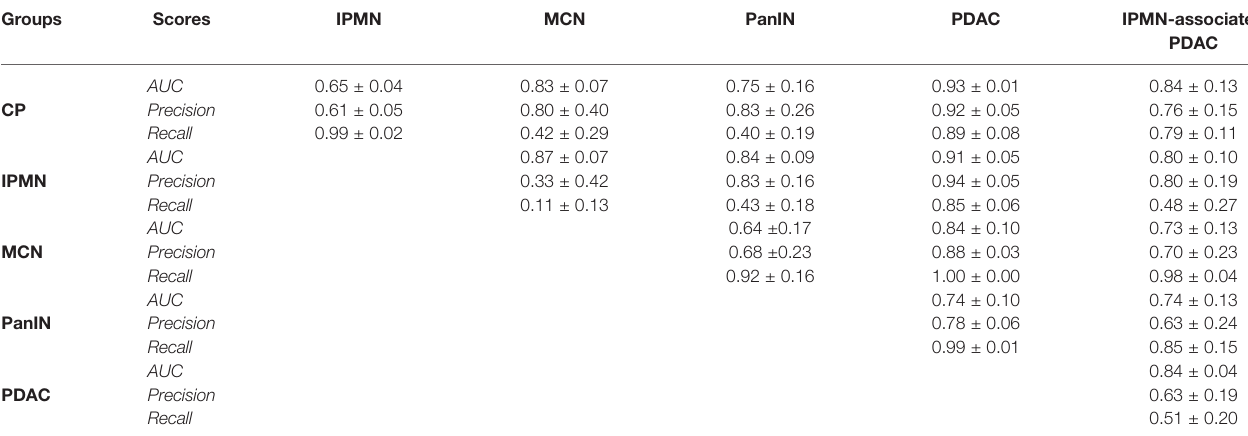
TABLE 2 | Classi fi cation metrics for the 15 pairwise CGAT classi fi ers from every point pattern set from each disease group. Groups